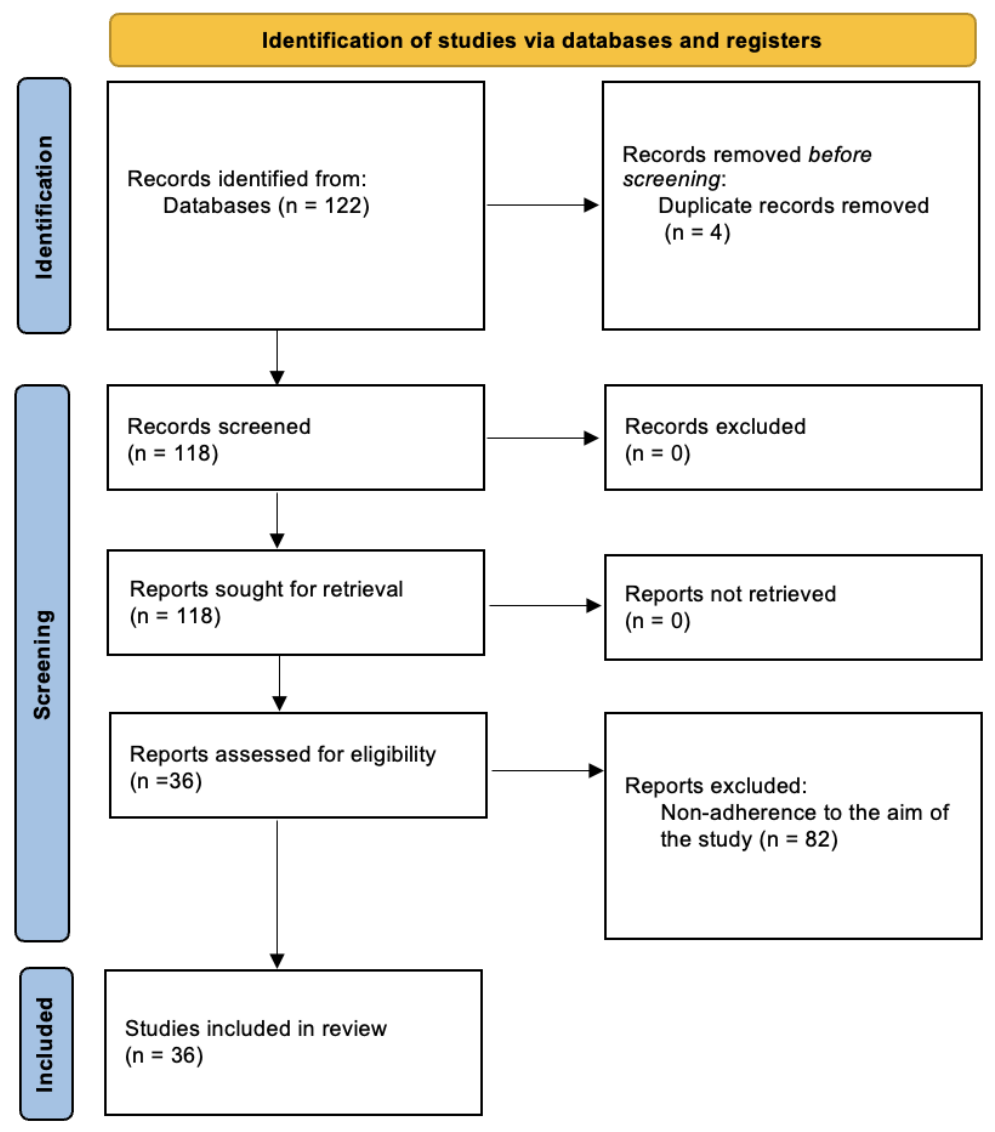
Figure 1. Prisma flow diagram for this systematic review.